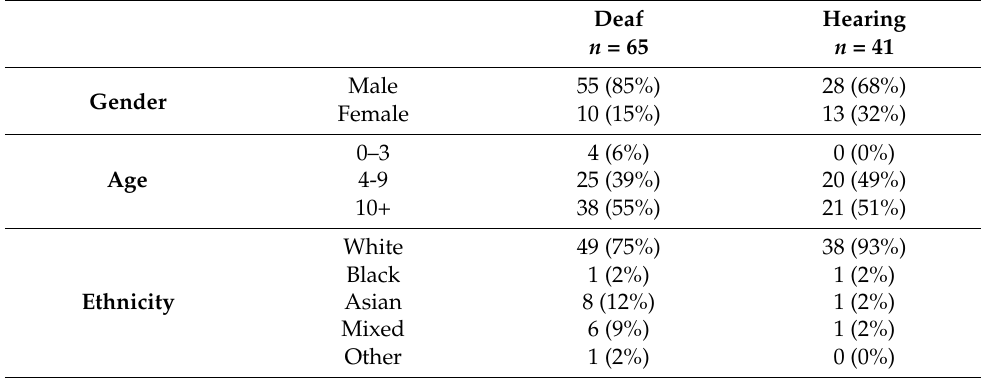
Table 1. Demographics of autistic deaf and hearing children/young